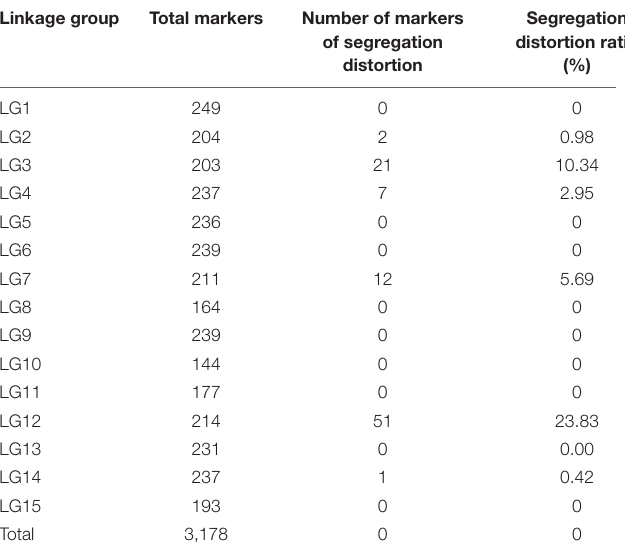
TABLE 4 | Distribution of distorted segregation markers in parental and integrated genetic